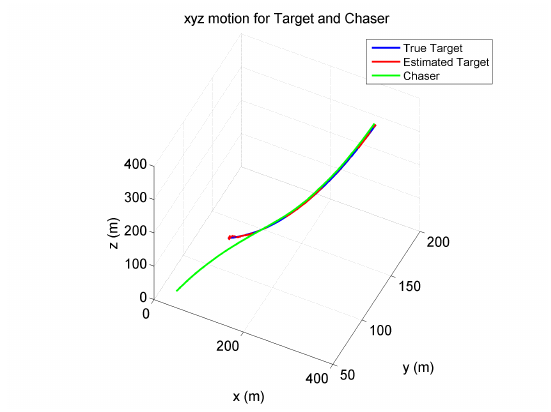
Figure 26. Estimation based target tracking in 3 D (Case